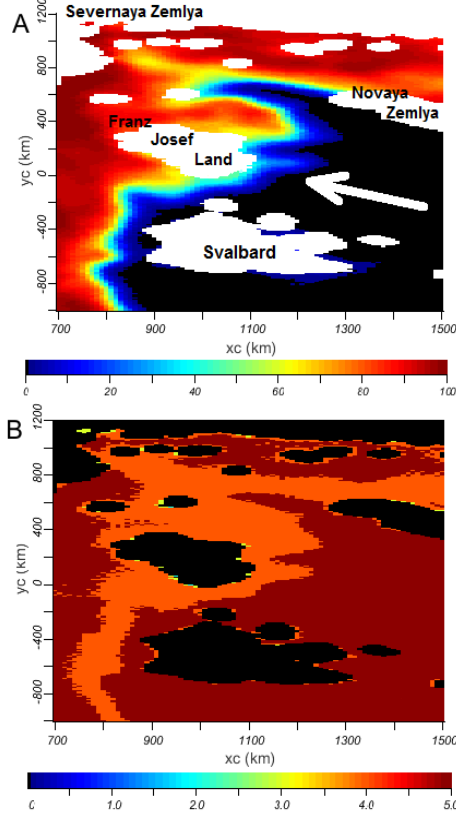
Fig. 6. General map of the Arctic Ocean in the polar stereographic projection No. 6 in NetCDF format issued by OSI SAF: A – ice concentration, B – relia- bility parameter (Visualization software: ncBrowse )